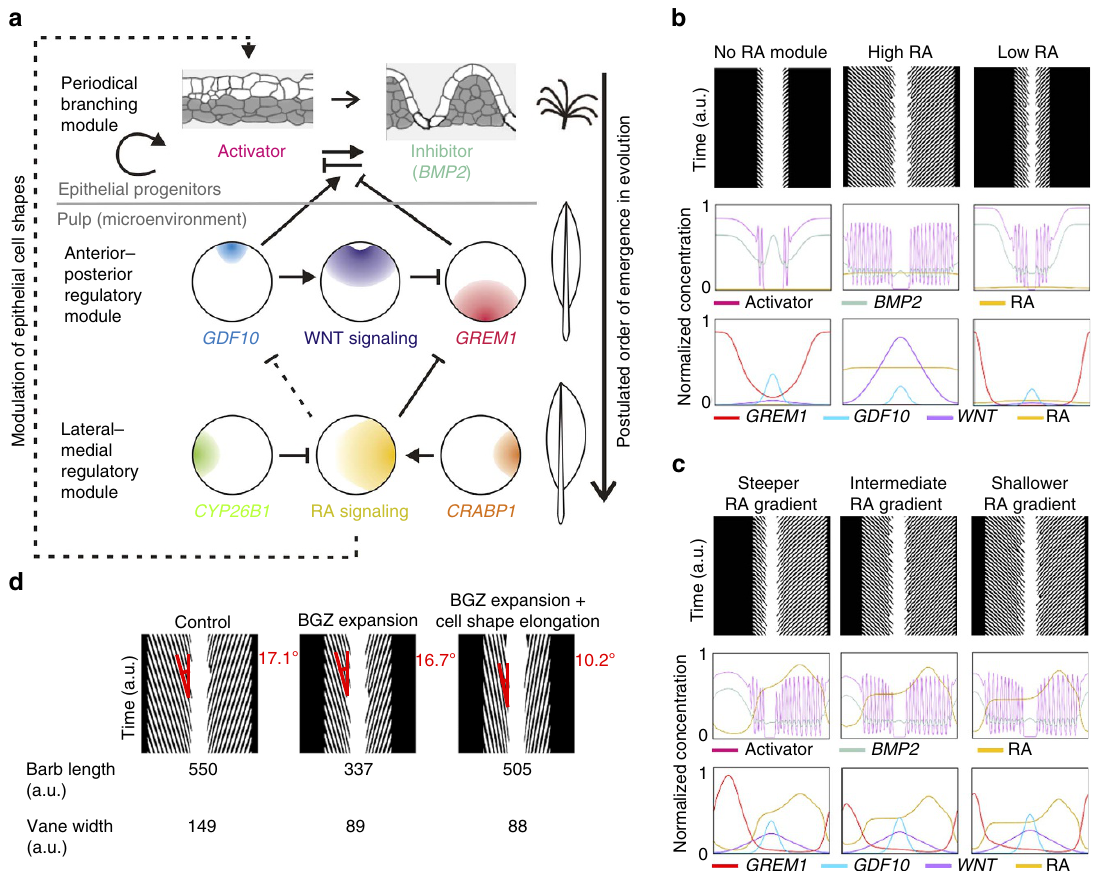
Figure 7 | A multi-module regulatory model of feather diversification. ( a ) Schematic representation of the infrastructure of the multi-module regulatory feather (MRF) model and the corresponding transformative events of feather shapes in evolution. Dashed lines denote crosstalk relationships not fully confirmed. The differential equations for quantifying the crosstalk relationships are listed in the Methods. ( b ) Representative simulations of vane shape variations using the MRF model either without RA module, with high RA ( CRABP1 level set at 1.1, CYP26B1 at 0.02, artificial unit), or with low RA ( CRABP1 at 0.005, CYP26B1 at 0.2). ( c ) Representative simulations of feathers with different levels of vane asymmetry by changing the slope of RA gradient ( CRABP1 at 0.006, CYP26B1 at 5 for the steeper RA gradient, CRABP1 at 0.03, CYP26B1 at 0.5 for the intermediate RA gradient, CRABP1 at 0.06, CYP26B1 at 0.3 for the shallower RA gradient), ( d ) Simulations of RCAS-GREM1 and RCAS-DNRARb infected feathers in which the BGZ expands without significantly shortening of